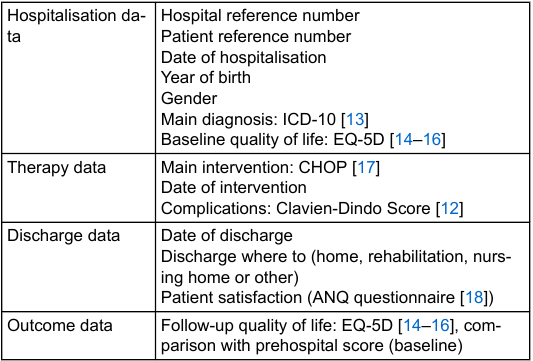
Table 1: The minimal dataset proposed by the SGC-SSC and